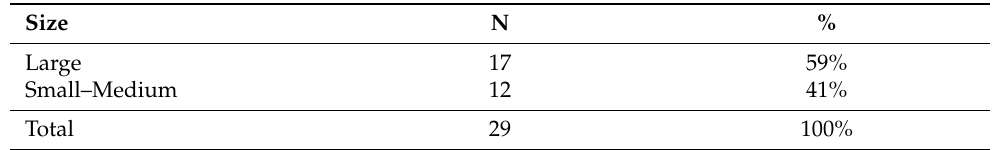
Table 2. Size Table 2. Size distribution.